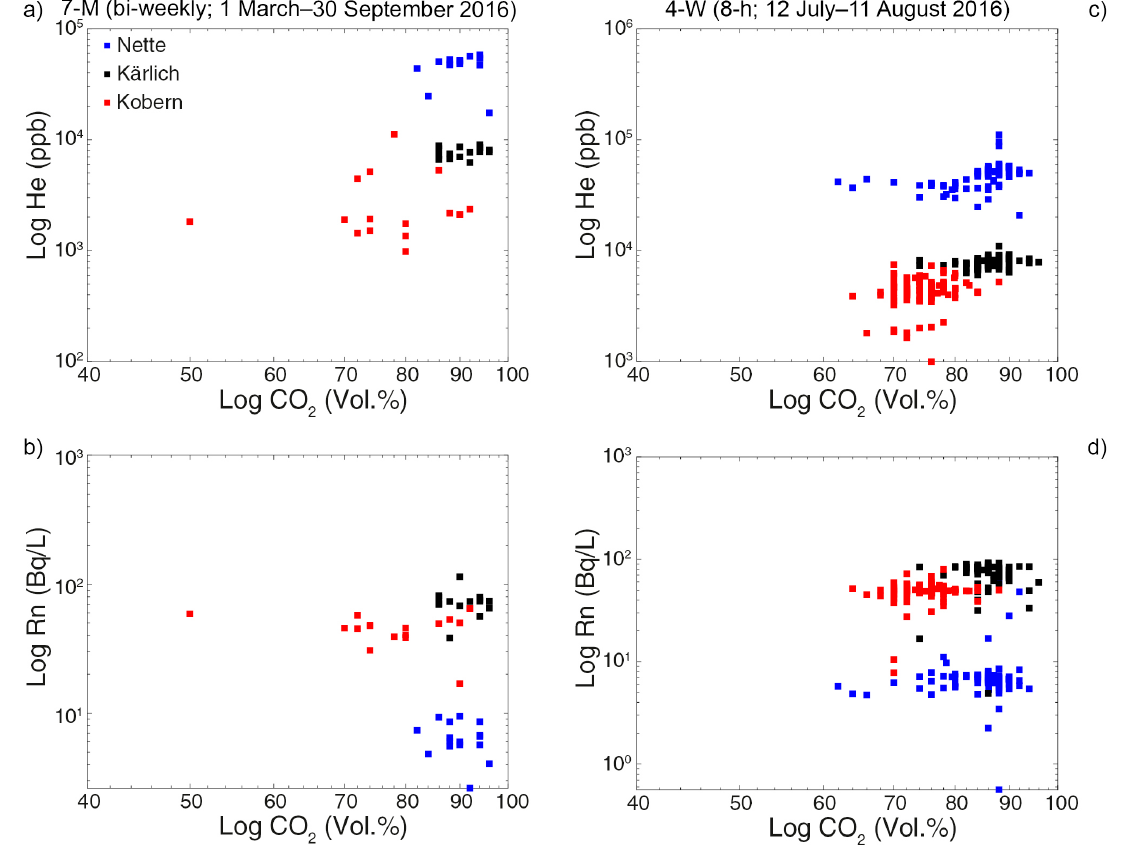
Figure 3. He vs. CO 2 ( a , c ) and Rn vs. CO 2 ( b , d ) emissions: Nette (blue squares), Kobern (red squares) and Kärlich (black squares).